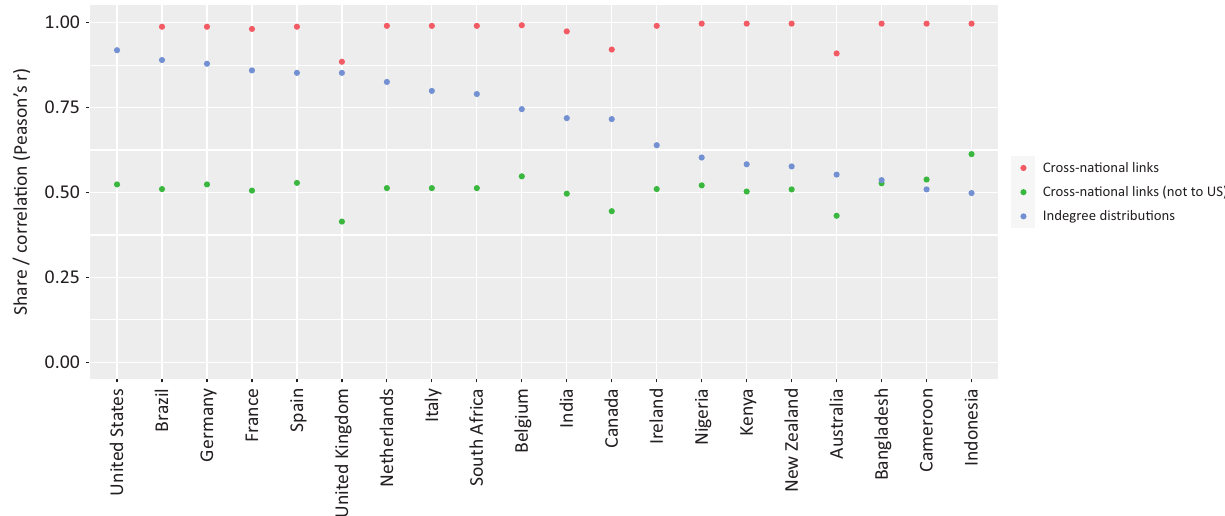
Figure 3. Network indicators (share of cross-national links and indegree correlation) per country. Notes: Only the 20 most frequent countries in the dataset were included. Sorted in descending order by indegree correlation. Network analyses were exerted with igraph for R. N (tweets) = 6,041,024; N (users/nodes) = 1,197,515; N (edges) = 4,260,896. Source: Author, prepared with R igraph and